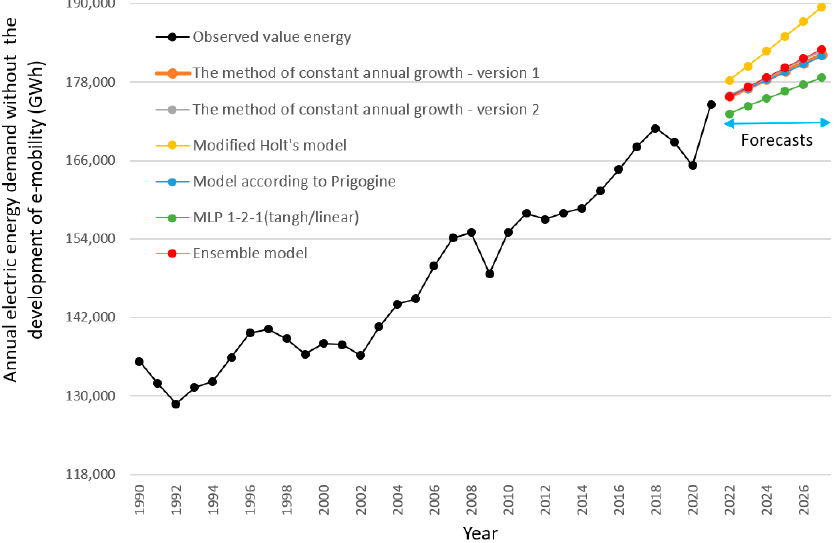
Figure 8. Time series of observed values of annual electric energy demand in Poland and results of forecasts from 2022 to 2027 obtained by six the methods.